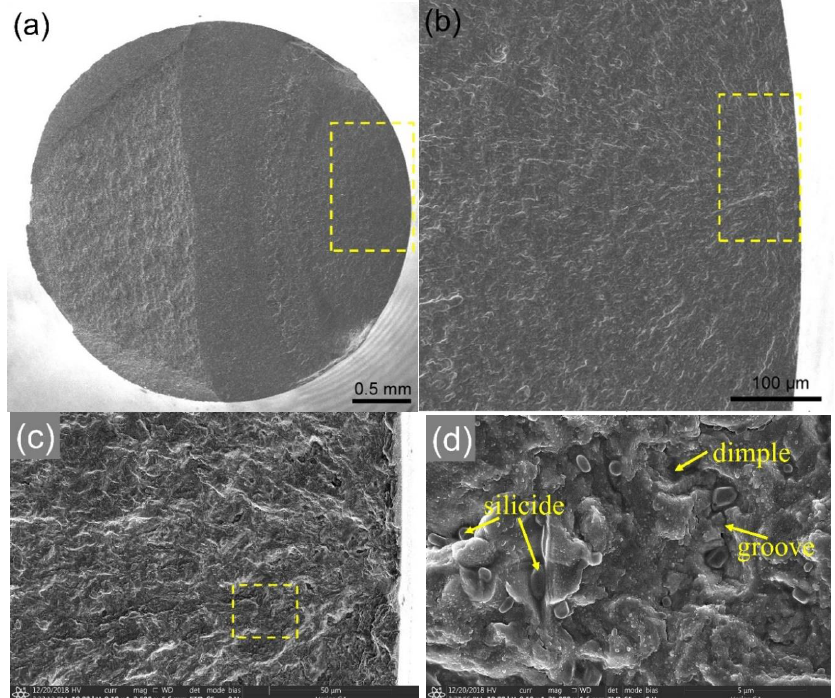
Figure 7. Fracture surface of an electropolished sample tested at σ a = 730 MPa, failed after N f = 6.39 × 10 5 cycles in the HCF regime: ( a ) overall view showing the surface crack initiation, ( b ) magnified image of the rectangular area in ( a ), ( c ) magnified image of the rectangular area in ( b ) showing the surface crack initiation morphology, ( d ) magnified image of the rectangular area in ( c ) revealing the morphology of the area near the crack initiation site. Metals 2020 , 10 , x FOR PEER REVIEW